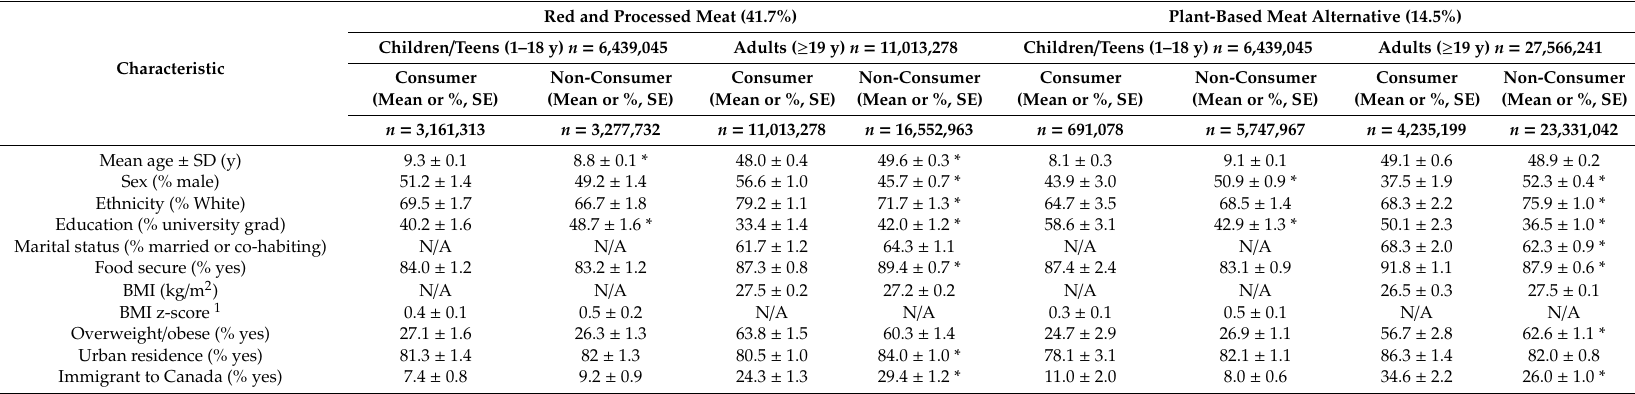
Table 2. Sociodemographic di ff erences between the red meat and plant-based alternatives consumers and non-consumers among Canadian children and adults.